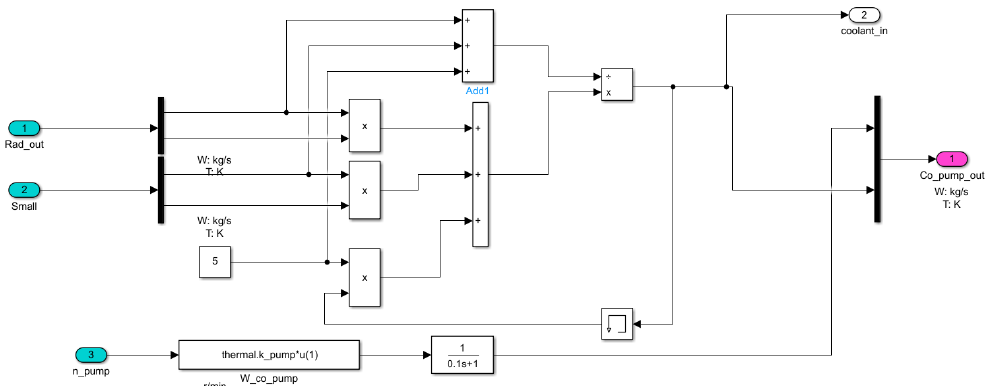
Figure 10. The Simulink model of the tank and pump.